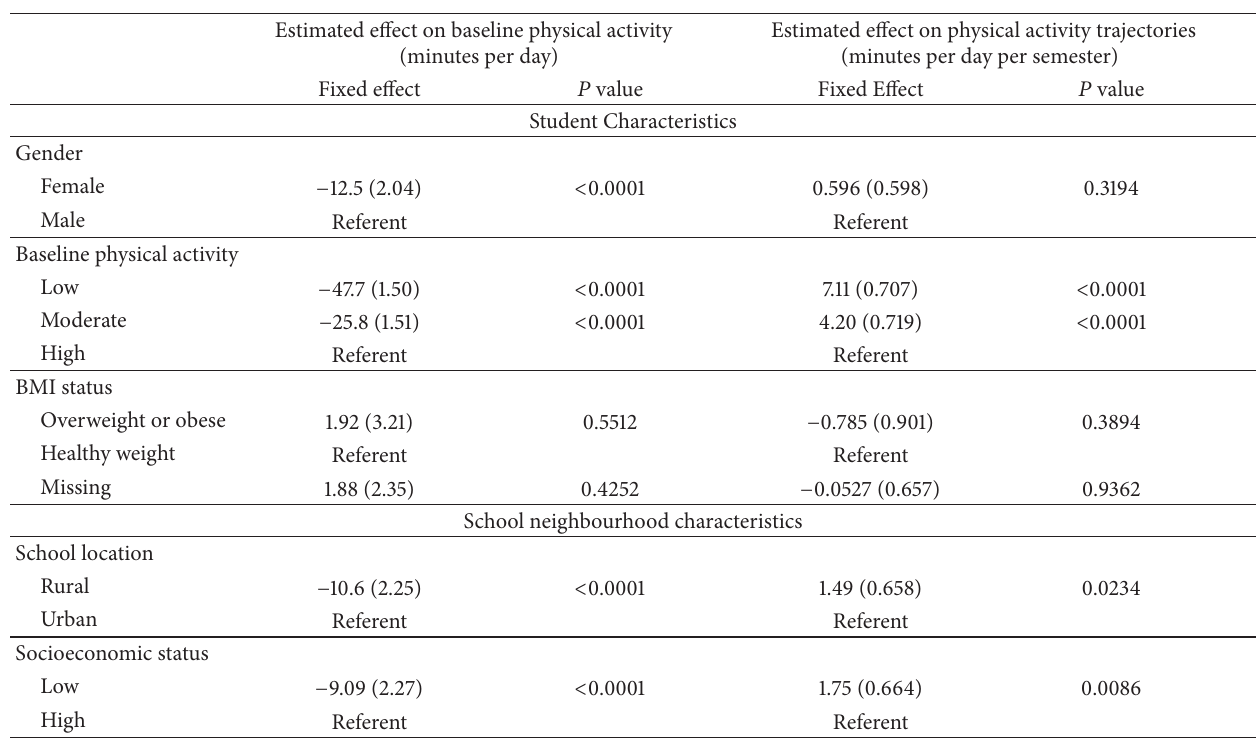
Table 3: Unadjusted linear growth curve modeling examining estimated effect on students’ baseline physical activity and physical activity trajectories.